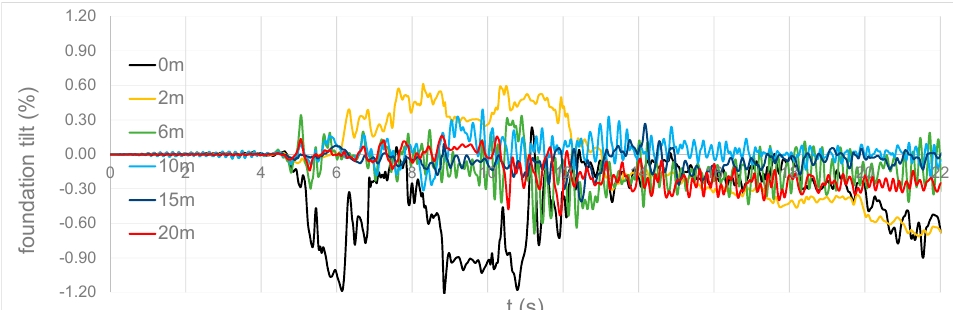
Figure 16. Foundation tilts. Table 5. Foundation settlements.